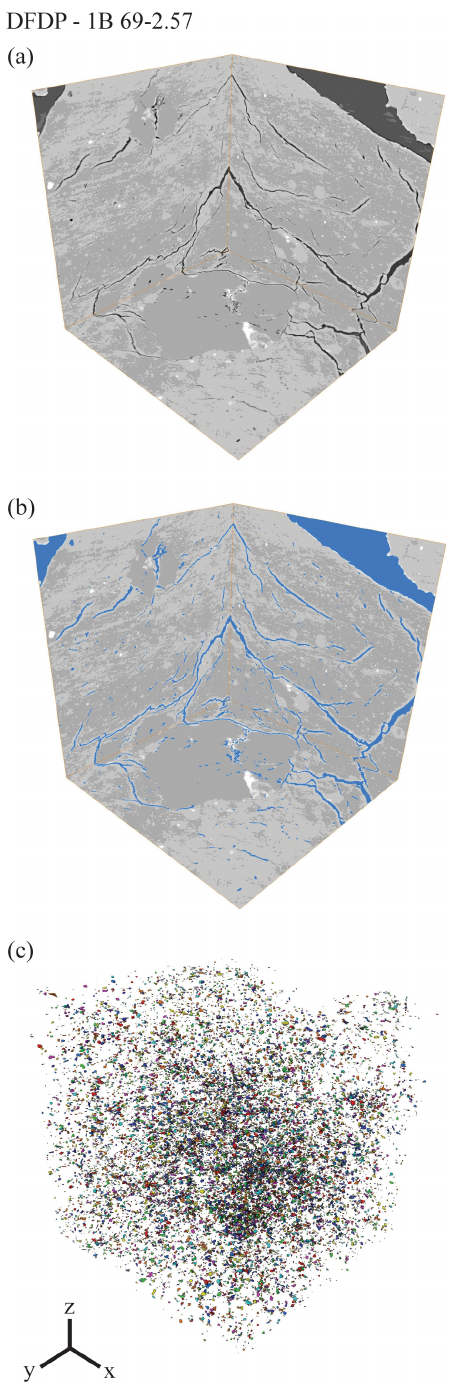
Figure 2. X-ray tomography data processing workflow. (a) Grayscale images in xy , xz , and yz directions (b) . Threshold of the darkest grayscale phase in each sample, corresponding to voids (pores and fractures). (c) 3D volume of the segmented pore spaces after removal of the fractures due to sample decompaction and cor- ing damaging